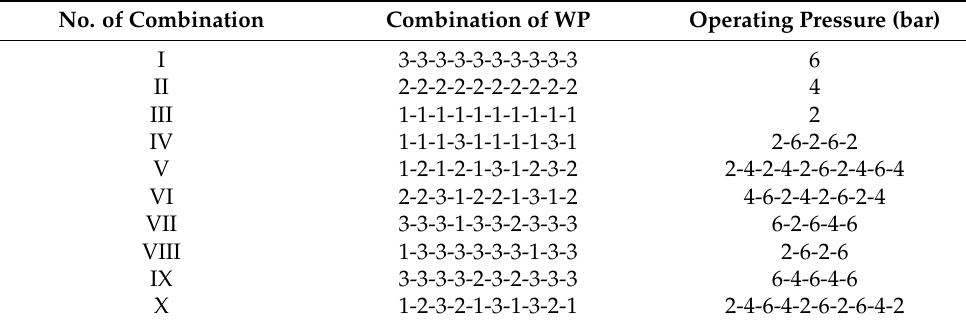
Table 3. Combinations of workpiece appearance.